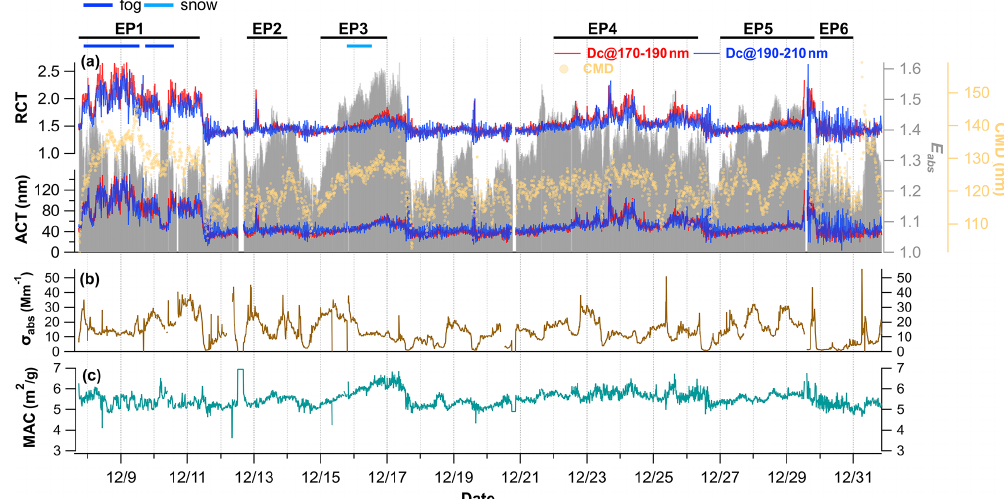
Figure 5. (a) Time series of the relative and absolute coating thicknesses of r BC-containing particles within the D c range of 170–190 and 190–210nm. The gray bars denote the absorption enhancement ( E abs ) of r BC. The light yellow circles denote the size of the r BC core. Time series of the (b) absorption coefficient ( σ abs ) and (c) mass absorption cross section